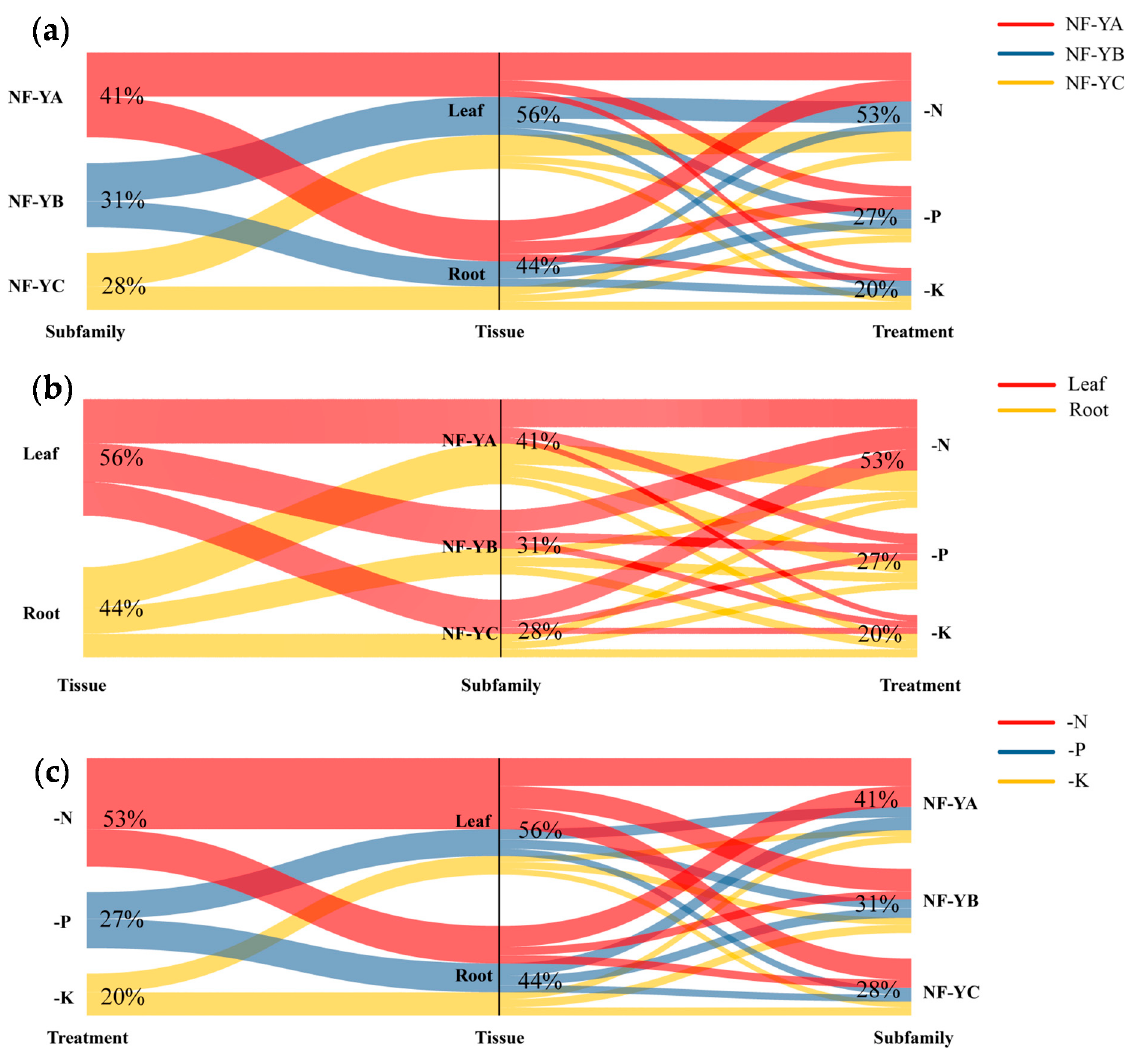
Figure 8. Genome distribution map of the differentially expressed NF-Y genes in two tissues under three nutrient starvations. Sankey diagram is drawn to depict the ratios of the differentially expressed NF-Y genes in one triad. ( a ) Three NF-YA subfamilies; ( b ) Two tissues; ( c ) Three nutrient deficiencies. -N: nitrogen deficiency; -P: phosphorus deficiency; -K: potassium deficiency. Distinct colors represent the flow of triads belonging to one category into the other two categories. The ratios of each triad are shown on the map.